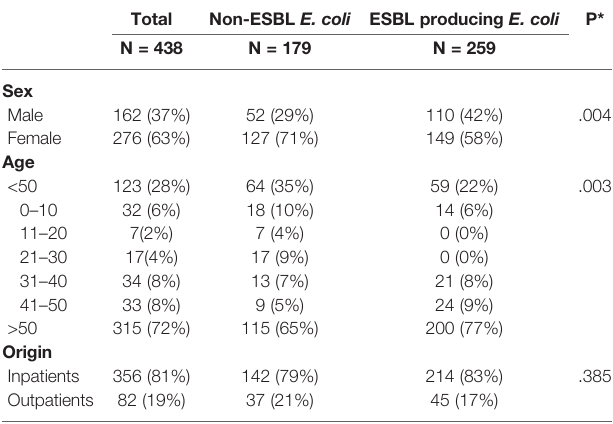
TABLE 1 | Analysis of some risk factors in urinary E. coli isolates from 2016 to 2019.